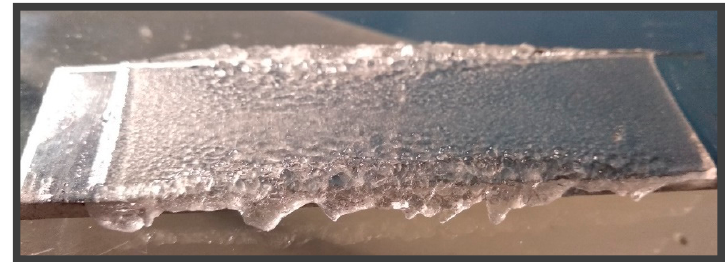
Figure 2. Glaze ice deposited on an AA6061-T6 substrate in INTA’s IWT.